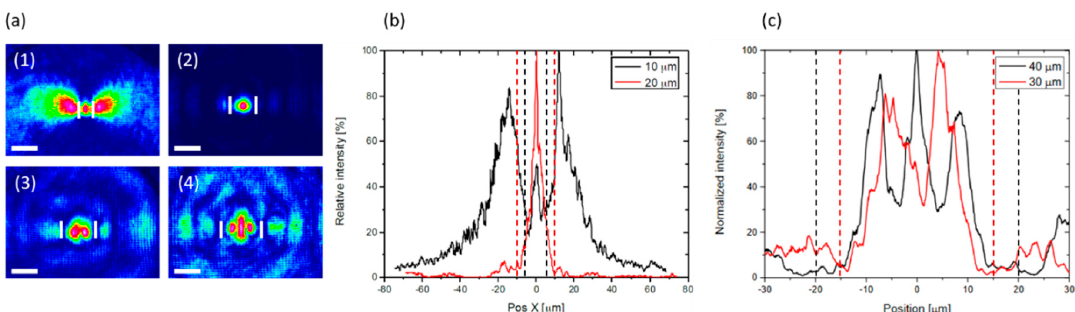
Figure 12. ( a ) Near-field helium-neon beam profile at the output of waveguides generated by two tracks separated by 10 µm (1), 20 µm (2), 30 µm (3), and 40 µm (4). Scale bar 20 µm, and white rectangles locate the double-track structure. ( b , c ) Horizontal cross-sections of CCD for track separations of 10 and 20 µm, and for track separations of 30 and 40 µm, respectively (unpublished results). Dashed lines indicate the respective positions of the double-track structures.